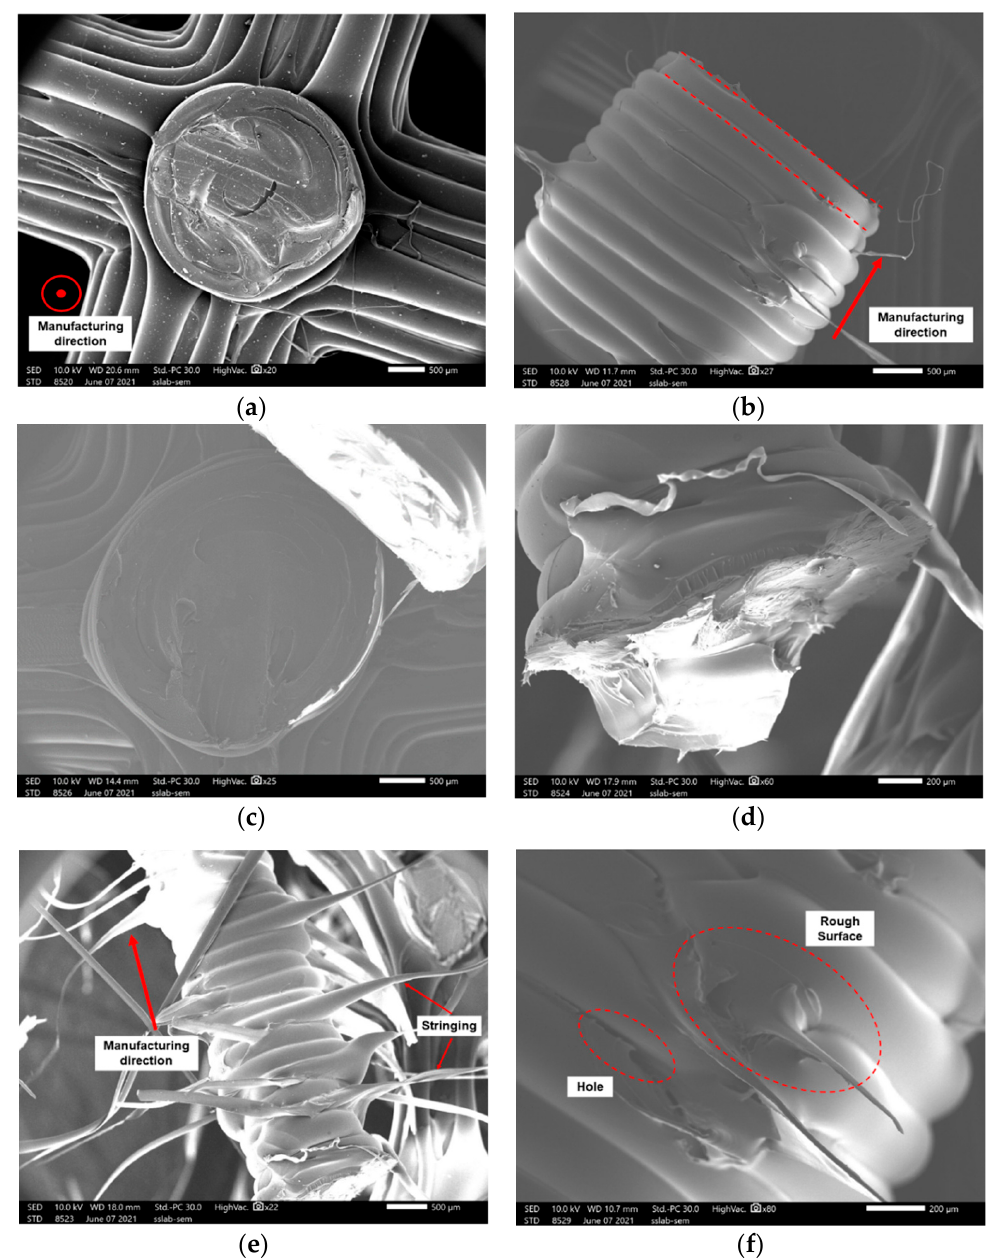
Figure 6. Deformation process of lattice structures: ( a ) cubic uniform, ( b ) cubic FGM, ( c ) honeycomb uniform, ( d ) honey- comb FGM, ( e ) bamboo uniform and ( f ) bamboo FGM.